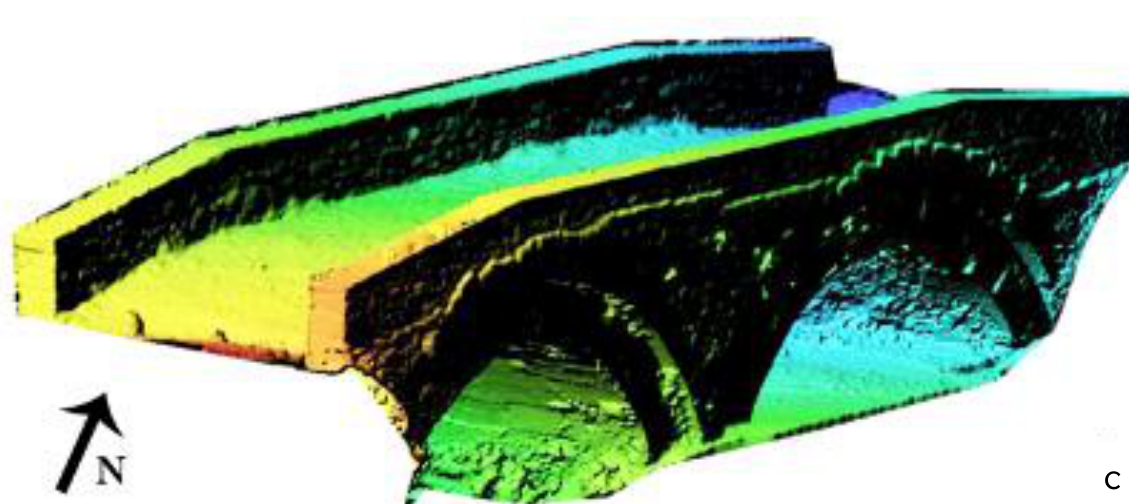
Figure 12. Digital Surface Model: ( a ) southeast front (AA’); ( b ) northwest front (BB’); ( c ) perspective view. The SUMs analyzed are affected by traces of widespread surface degradation such as vegetation, crusts, and patinas. The few documentary sources relating to this artifact and the few data so far in possession regarding this portion of the territory do not